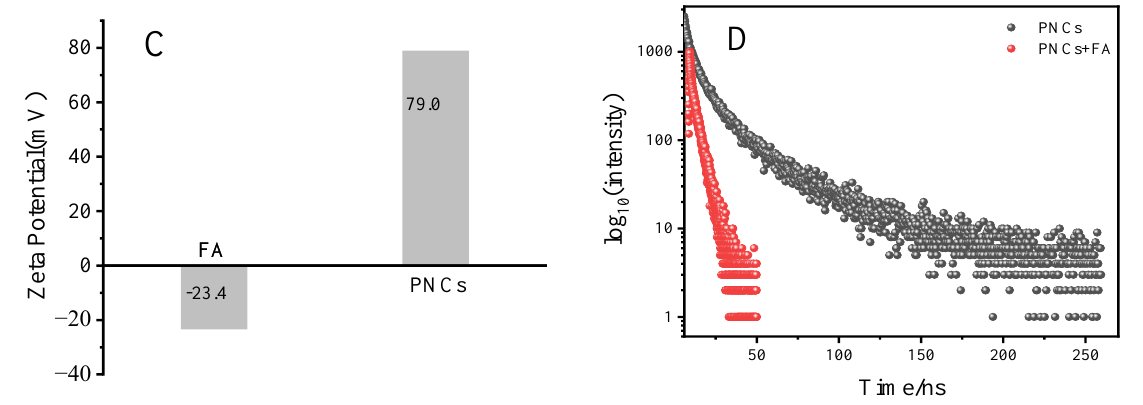
Figure 8. The fluorescence emission of CsPbBr 3 /Cs 4 PbBr 6 PNCs, FA, and CsPbBr 3 /Cs 4 PbBr 6 after adding FA spectra ( A ); the fluorescence excitation spectra of CsPbBr 3 /Cs 4 PbBr 6 PNCs and FA; UV- Vis absorption spectra of CsPbBr 3 /Cs 4 PbBr 6 PNCs, FA, CsPbBr 3 /Cs 4 PbBr 6 PNCs after adding FA ( B ); the Zeta potential of FA and CsPbBr 3 /Cs 4 PbBr 6 ( C ) and fluorescence lifetime decay curves of CsPbBr 3 /Cs 4 PbBr 6 in the presence and absence of FA ( D ). Experimental conditions: the concentration of CsPbBr 3 /Cs 4 PbBr 6 PNCs (0.156 mmol, in terms of Cs atoms), the concentration of FA was 20 μM. The reaction temperature was 25 °C; the response time was 5 min. Table 2. PL decay parameters of the CsPbBr 3 /Cs 4 PbBr 6 PNCs and CsPbBr 3 /Cs 4 PbBr 6 PNCs/FA mixture.